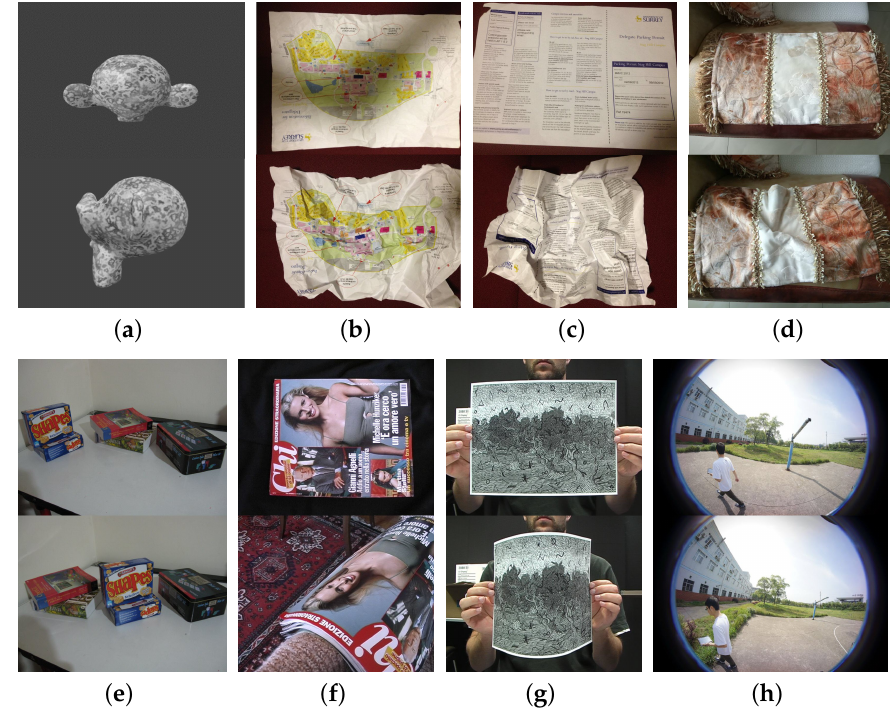
Figure 6. ( a – h ) The non-rigid dataset (close-range dataset